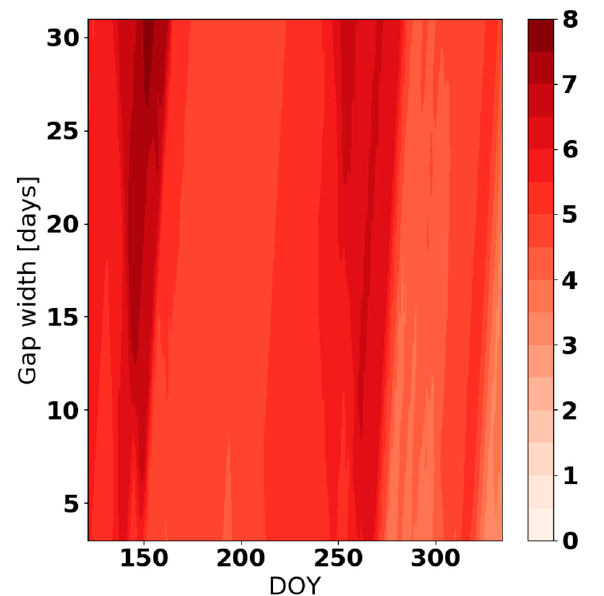
Figure 10. Standard deviation of observed data which were used for bias correction for DOY 121–334 in 2017 in Gumpenstein (Austria).